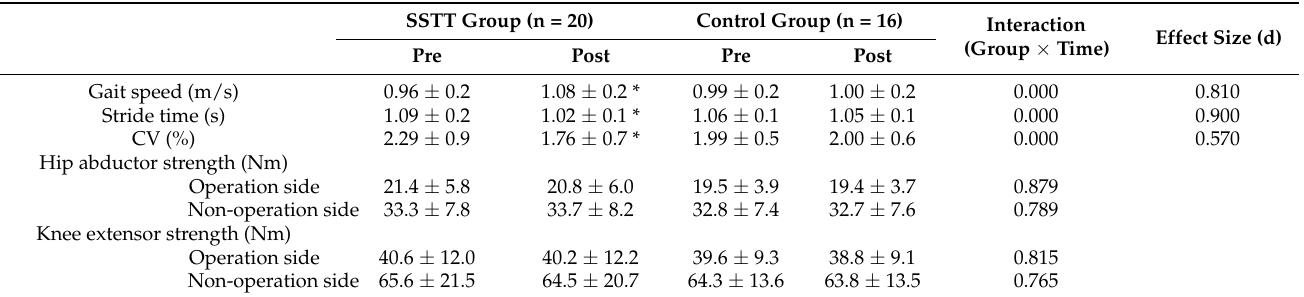
Table 2. Comparison of gait function and lower extremity muscle strength between SSTT and control